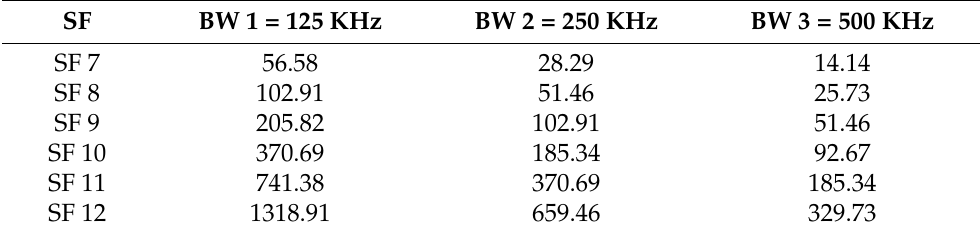
Table 8. Time on-air (ToA) (ms) at code rate (CR)